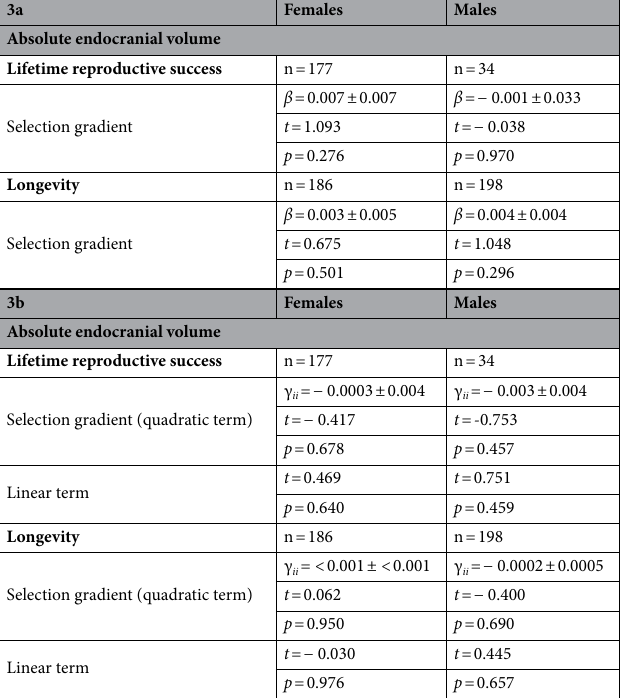
Table 3. Linear (3a) and quadratic (3b) selection gradients (GLMs) for absolute endocranial volume in females and males. Selection gradients are the estimate ± the standard error. β indicates the linear selection gradient, γ ii the quadratic selection gradient, t the t-value, and p the